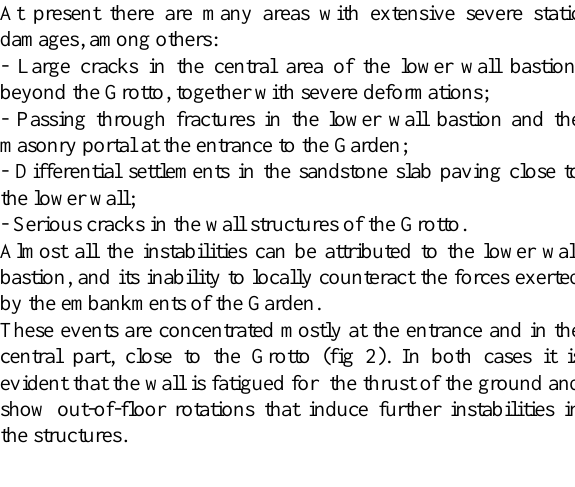
Figure 2. Examples of the instabilities in the